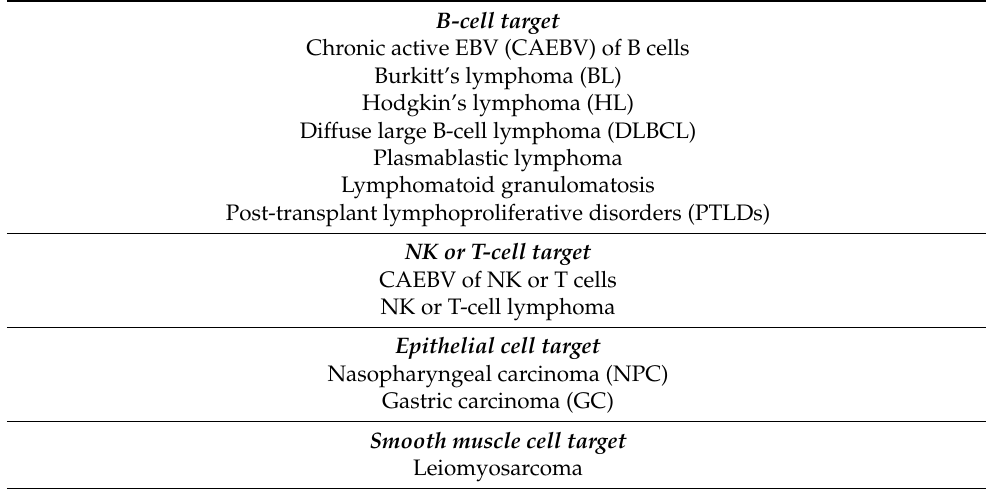
Table 1. EBV-associated lymphoproliferative disorders (LPDs) and